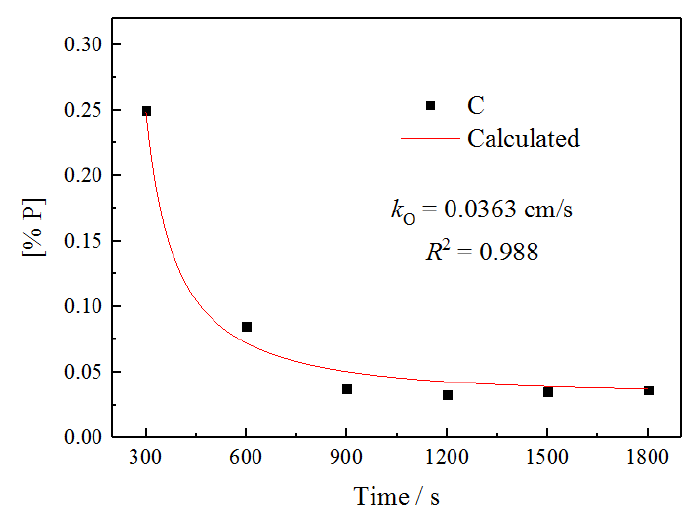
Figure 8. Fitting results of experiment C data.